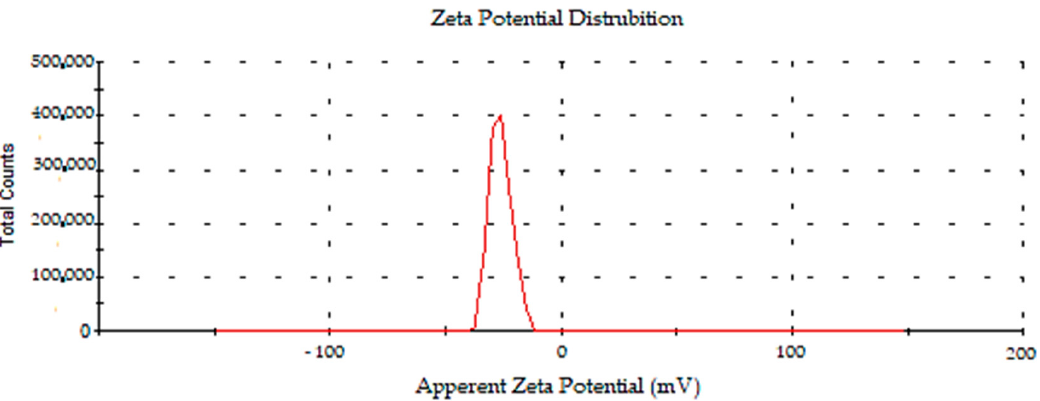
Figure 7. Zeta potential distribution of synthesized AC-AuNPs.